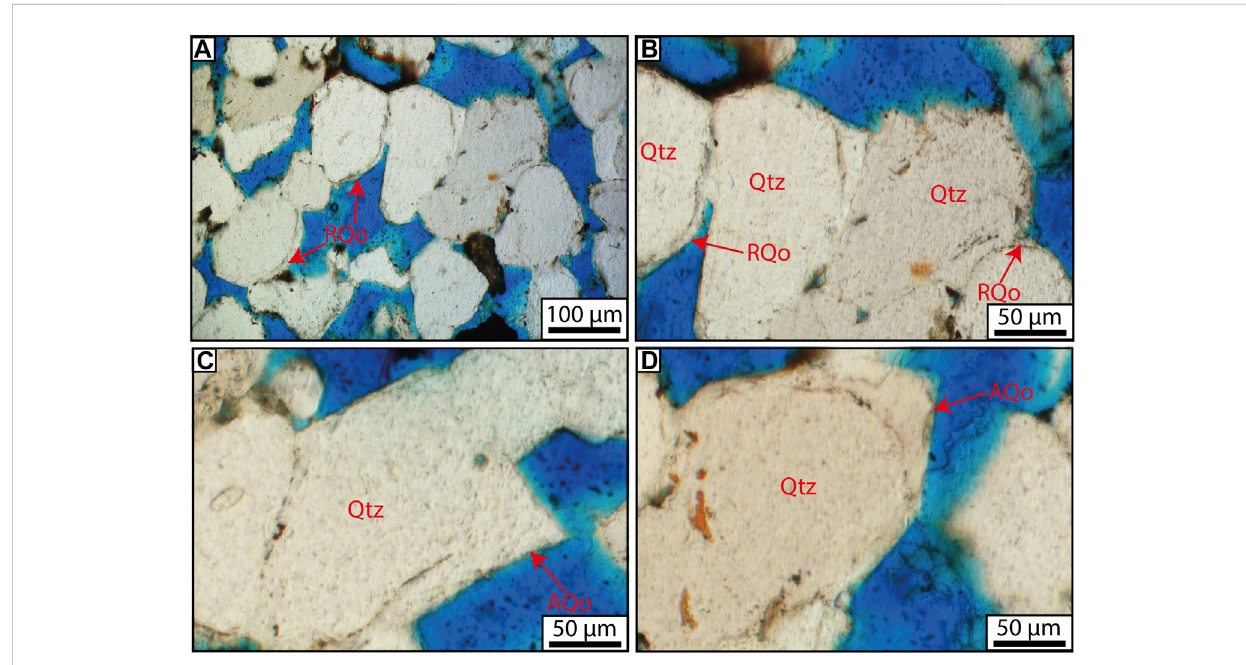
FIGURE 11 Thin-section photomicrographs showing the types of quartz overgrowths in the sandstones. (A, B) Rounded quartz overgrowths (RQo) occurring around detrital quartz grains. (C, D) Angular quartz overgrowths (AQo) occurring on detrital quartz